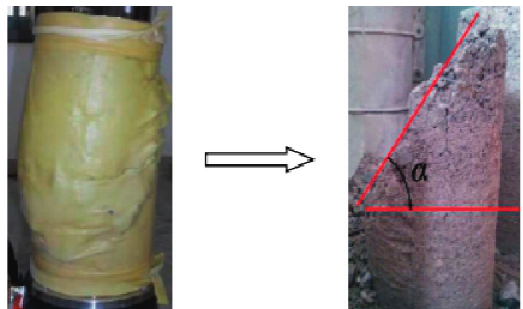
Figure 5: The final failure modes of specimens for LCSG